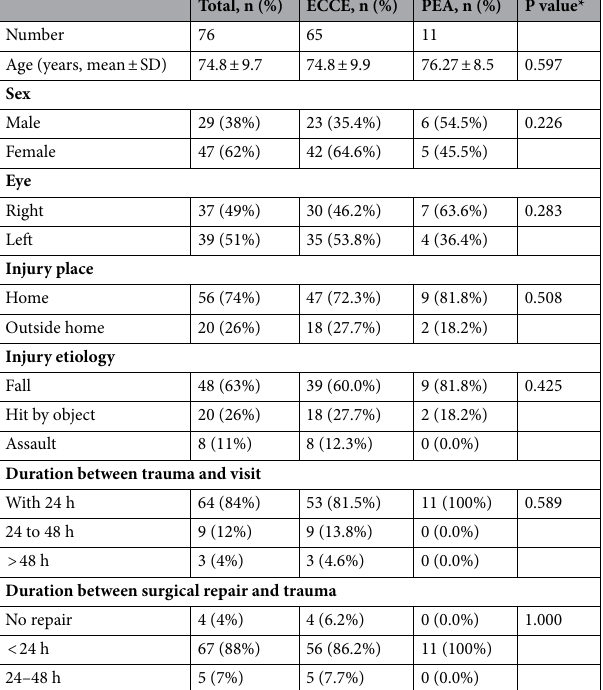
Table 2. Demography and characteristics of patients with traumatic cataract wound dehiscence. ECCE extracapsular cataract extraction, PEA phacoemulsification. *P value of statistical test between ECCE and PEA.